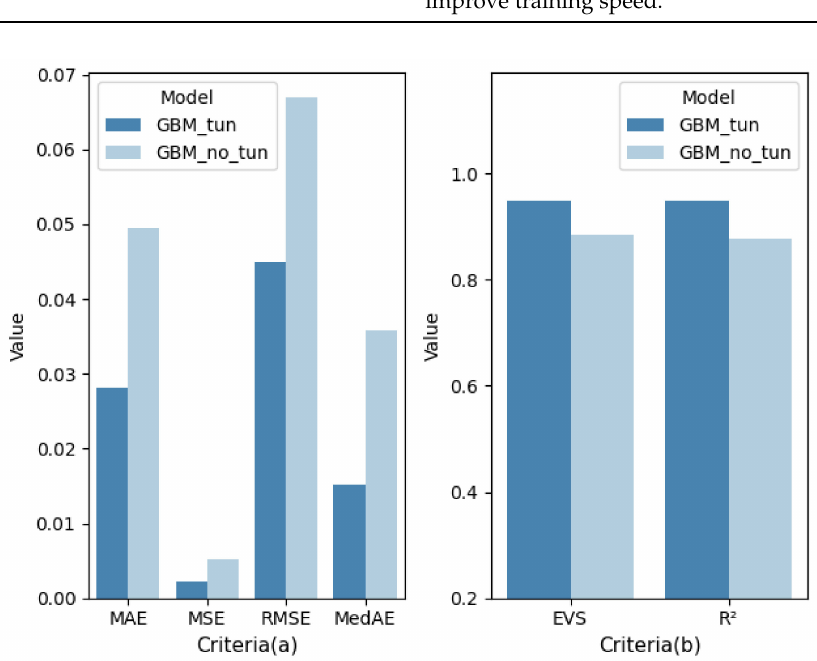
Figure 13. Comparison before and after LightGBM tuning by 10-fold cross-validation under different evaluation criteria: ( a ) The lower the criteria value, the better the model performance; ( b ) The higher the criteria value, the better the model performance.